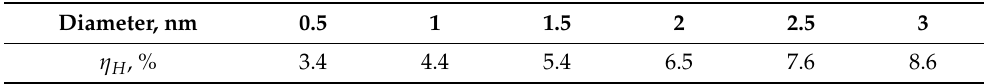
Table 1. Mass capacity of hydrogen in a beam of nanotubes of different diameters [5,31]. Diameter, nm 0.5